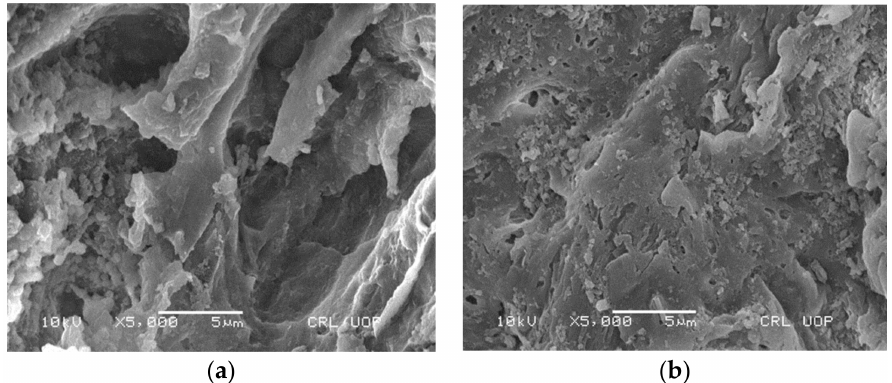
Figure 1. SEM image of WGTLs before ( a ) and after ( b ) sono-adsorption